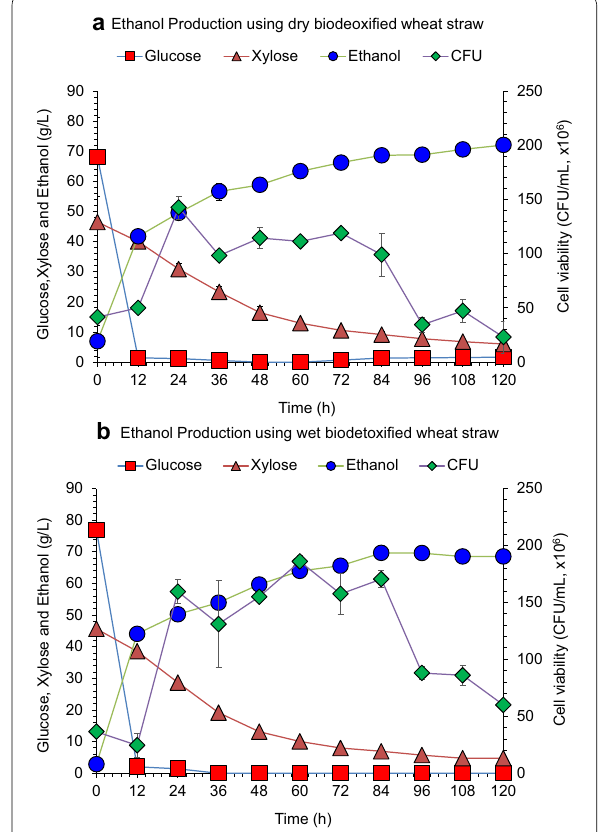
Fig. 2 Evaluation of dry and wet biodetoxified wheat straw feedstocks on simultaneous saccharification and ethanol co-fermentation (SSCF). a SSCF using dry biodetoxified wheat straw with CaCO 3 powder; b SSCF using wet biodetoxified wheat straw with 20% of Ca(OH) 2 slurry. Conditions: 30% solids loading, cellulase dosage of 10 mg total protein/g cellulose, 10% (v/v) inoculum ratio